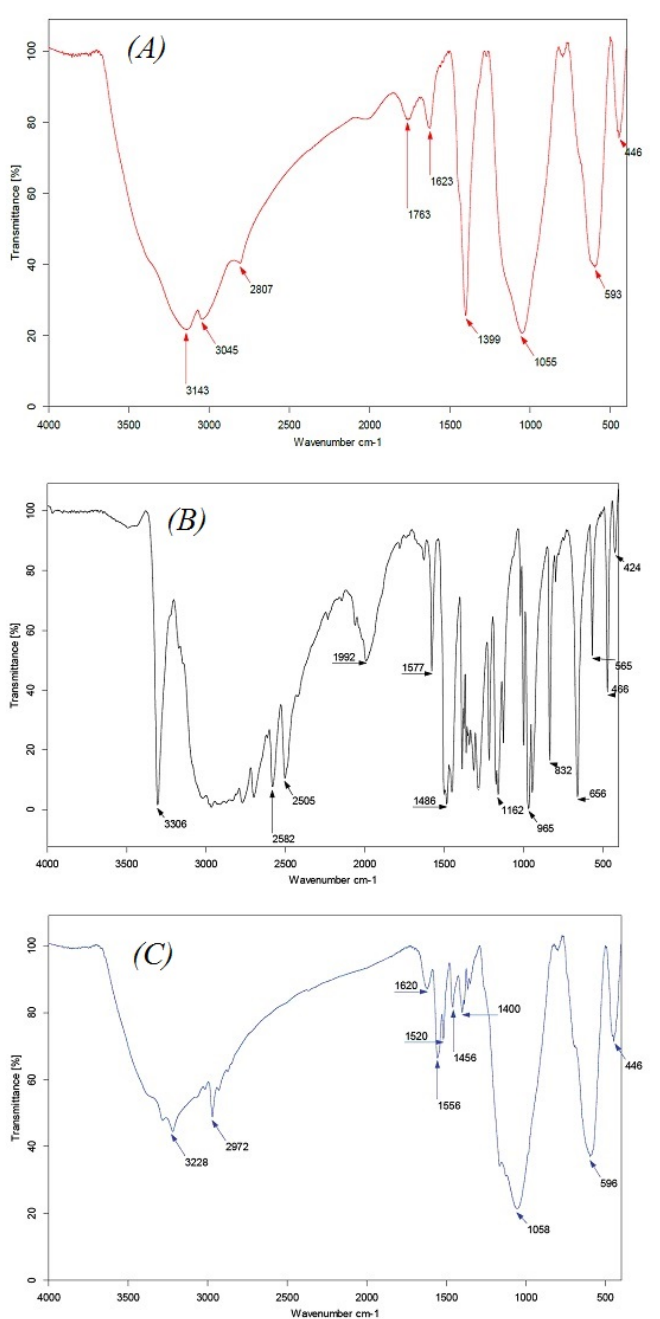
Fig. 4. FT-IR spectra of (A) the magnetic Fe O nanoparticles functionalized by 3-(Chloropropyl)-trimethoxysilane, (B) the product 3 4 of reaction of carbon disulfide and isopropylamine, and (C) the synthesized final